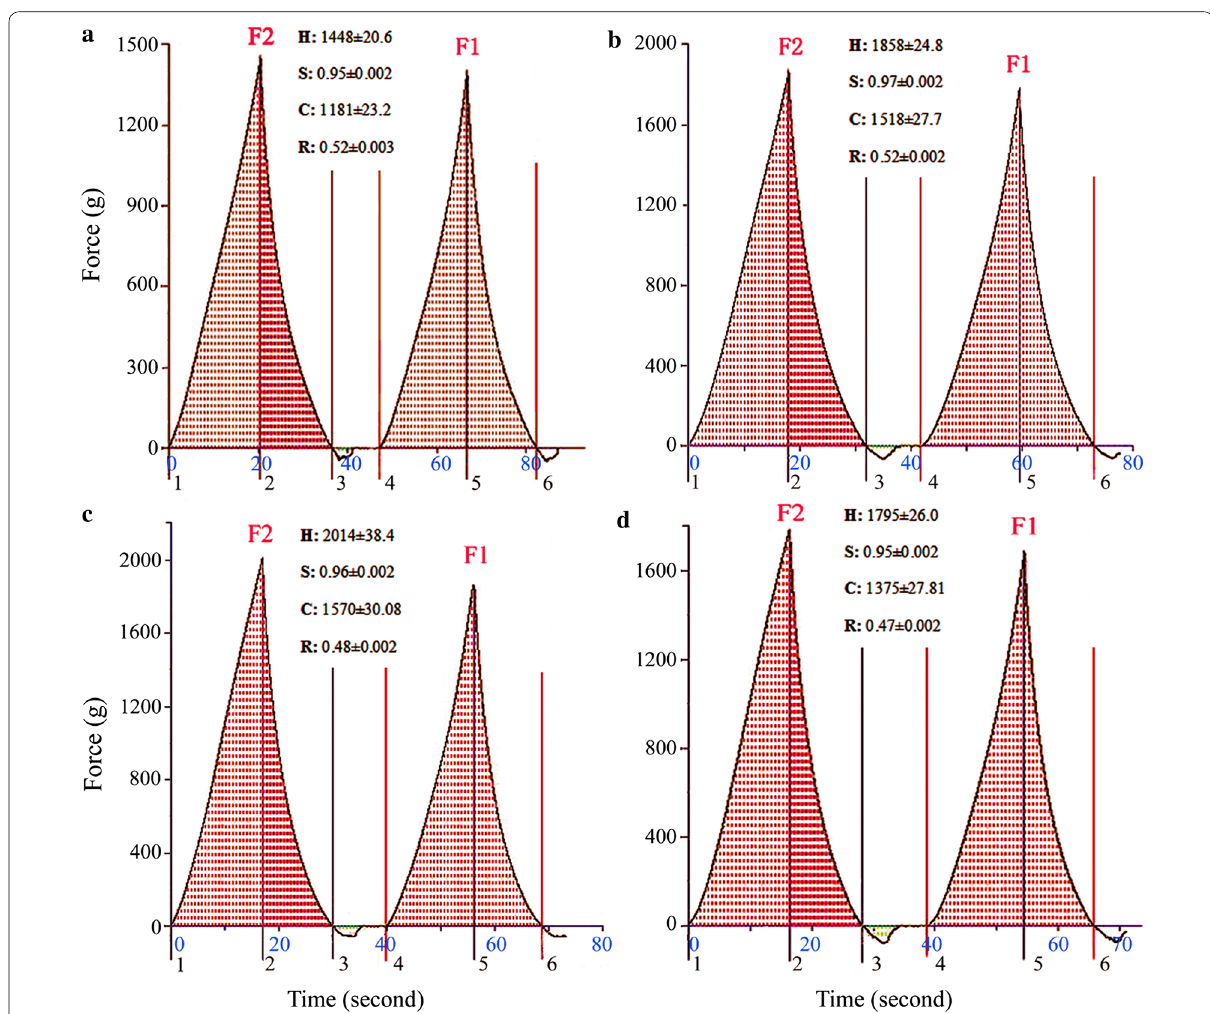
Fig. 6 Texture profile analysis of CSBs treated by FB G . a The reference; b 0.025 ml/g; c 0.05 ml/g; d 0.10 ml/g. Interpretation of texture parameters: Hardness F2; Springiness time 4–5 /time 1–2 ; Chewiness = =